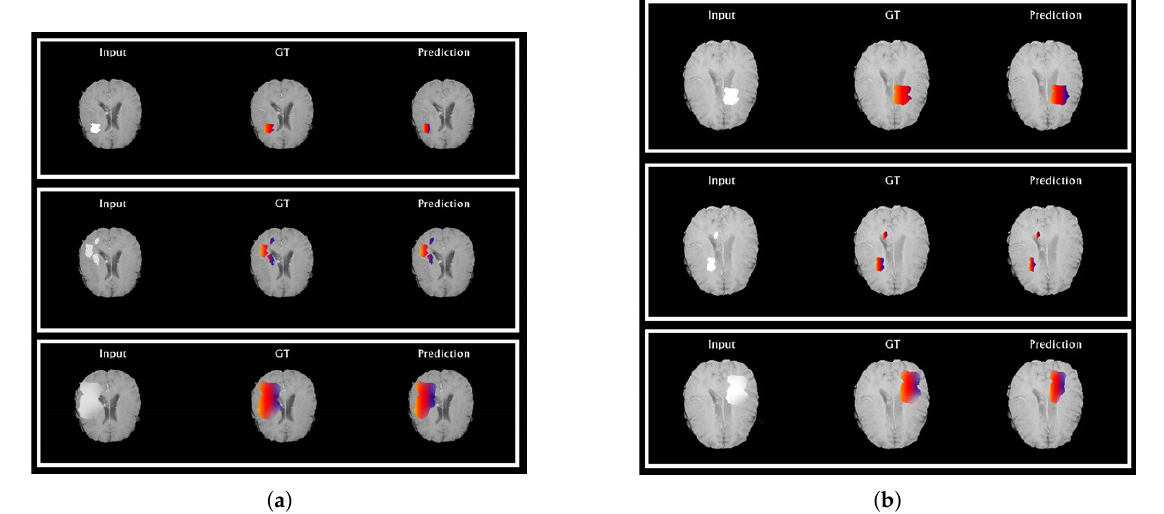
Figure 6. Automatic segmentation results of HGG ( a ) and LGG ( b ) cases. Red: edema, blue: non-enhancing tumor. From left to right: (i) original image, (ii) ground truth, and (iii) demonstration of automatic segmentation results from the proposed method. ( a ) The segmentation results of HGG cases compared to their ground truth and ( b ) the segmentation results of LGG cases compared to their ground truth.